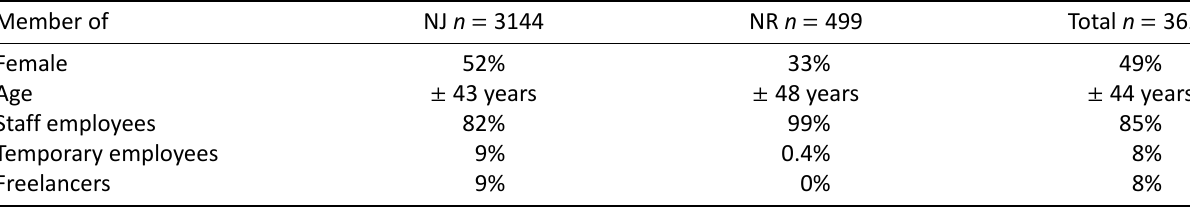
Table 1. Demographic